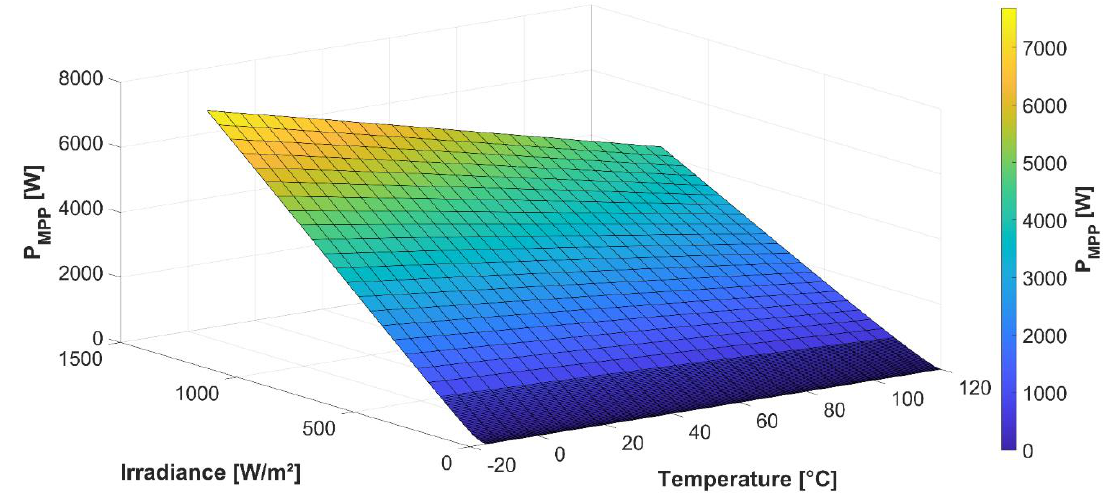
Figure 2. Characteristic diagram of P MPP f(T,G).